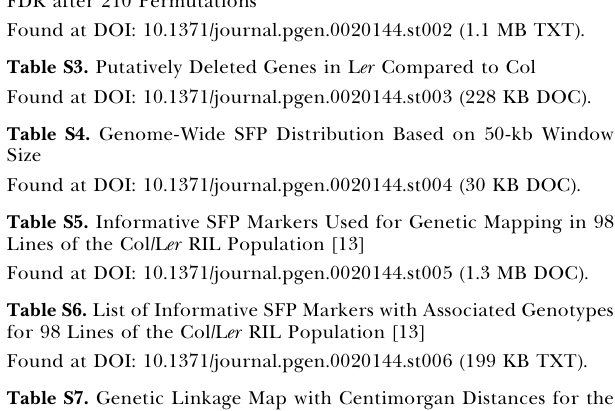
Table S8. Genome-Wide Statistics on Interval Sizes and Number of Genes per Genetic Interval Based on Informative SFP Markers and on Interval SFP Markers Table S9. Genes Marking the Beginning and End of Each Recombi- nation Interval for the 98 Lines of the Col/L er RIL Population [13] Found at DOI: 10.1371/journal.pgen.0020144.st009 (1.5 MB DOC). Table S10. Recombination Rates for Five Arabidopsis